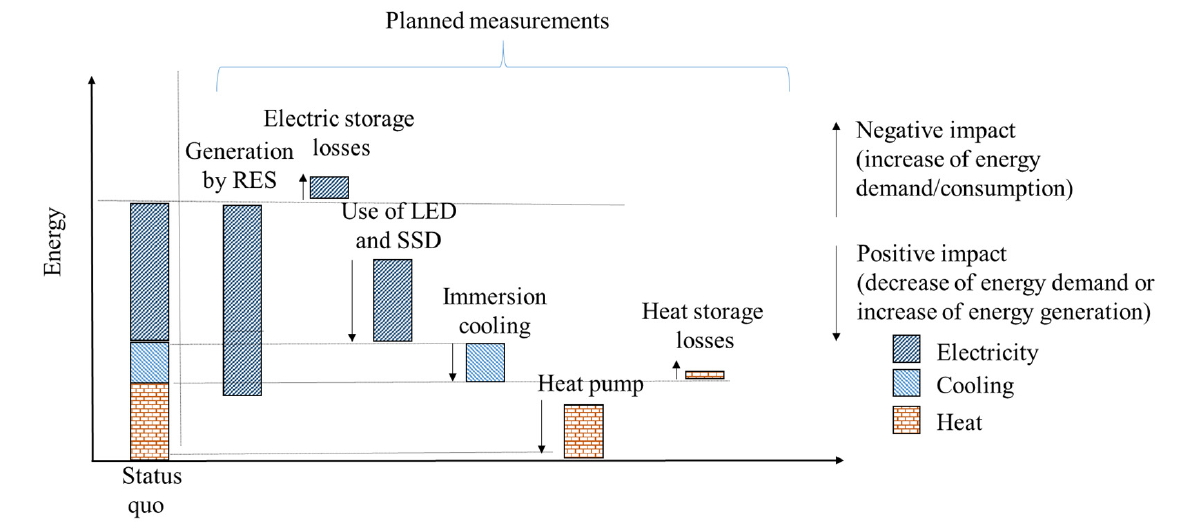
Figure 8. Qualitative visualization of the effect of the planning measurements of the Net-Zero Energy System.